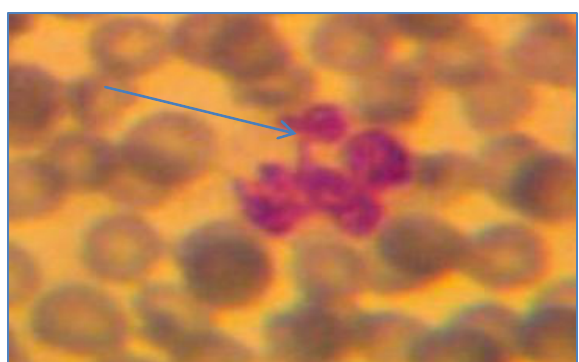
Figure, 3: Small club shape (1000 x)